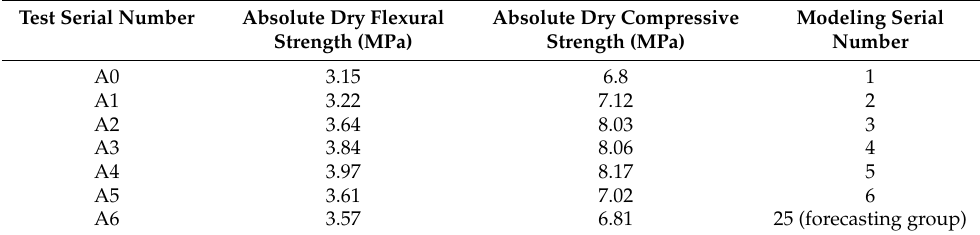
Table 4. Modeling